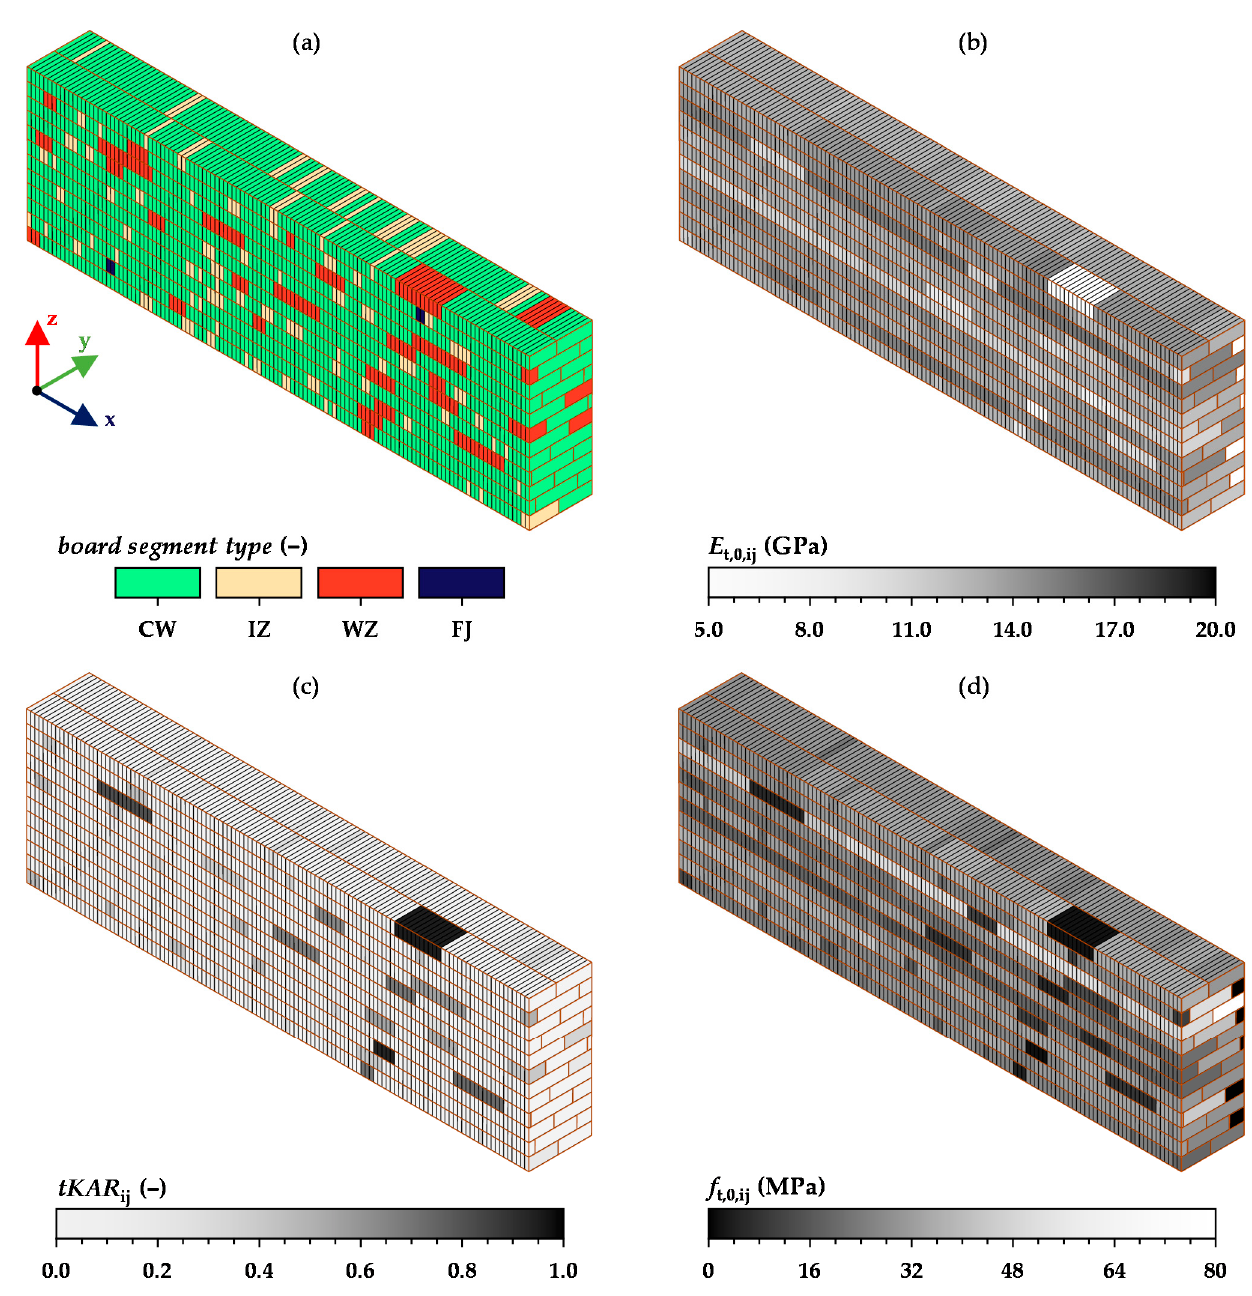
Figure 18. Exemplary representation of one flex_GLT beam type B part as implemented in stochastic FE-analysis: ( a ) board segment type {CW—Clear wood; IZ—Intermediate knot zone; WZ—Weak zone; FJ—Finger joints}; ( b ) modulus of elasticity in tension parallel to the grain ( x -axis); ( c ) tKAR -value; ( d ) tensile strength parallel to the grain ( x -axis).